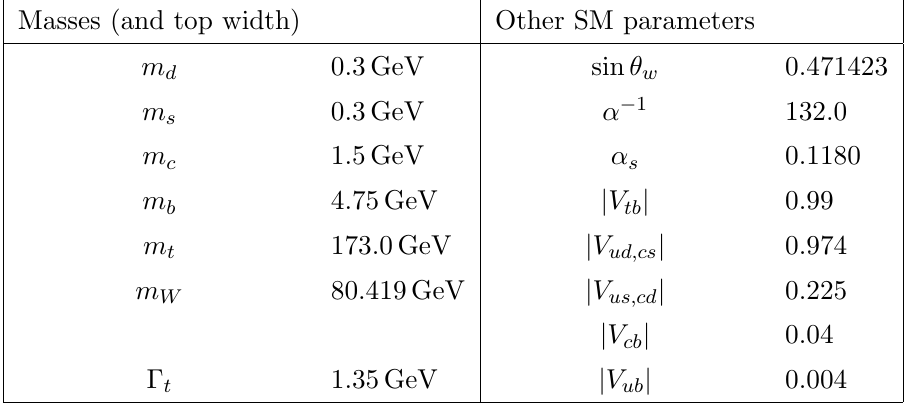
Table 1 . Numerical values of the SM parameters used in the